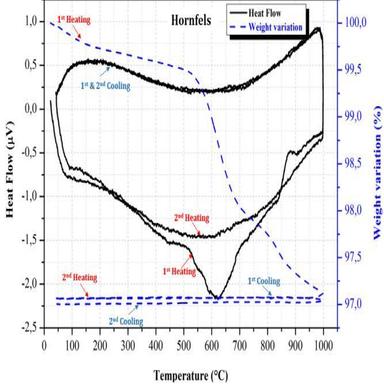
Mass loss and heat flow variation during two thermal cycles for Hornfels rock.